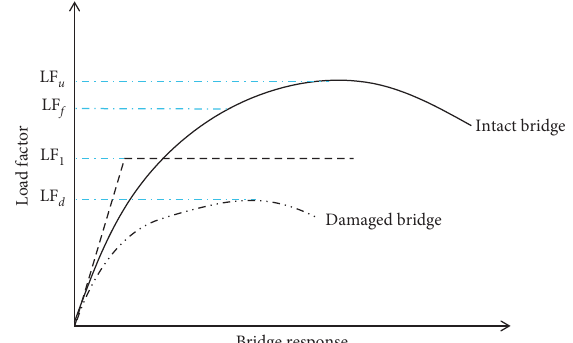
Figure 2: Representation of typical behavior of a bridge system [16].